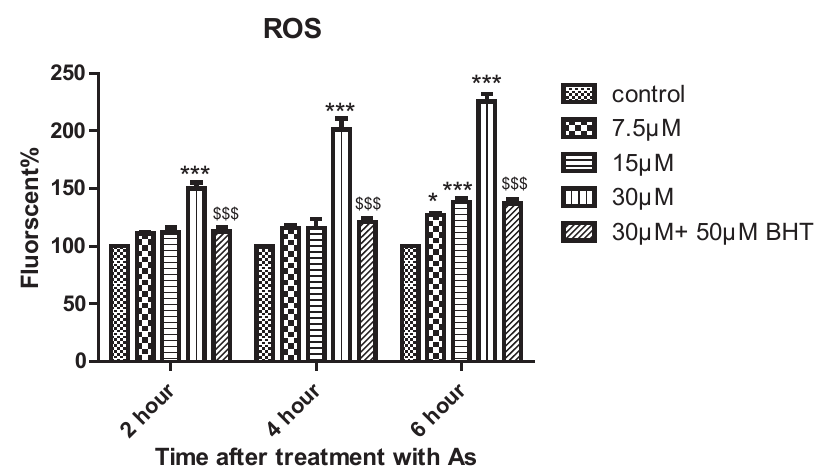
Figure 2: ROS generation in human lymphocyte after treatment with As. Induction of ROS by As was significant (P < 0.05) at all concentrations at 6 h and only at highest concentration at 2 and 4 h in comparison with control. Buyhylatedhydroxy toluene (BHT), an antioxidant, inhibited As-induced generation of ROS in human lymphocytes. * (P < 0.05) and *** (P < 0.001): significant difference compared to the control group. $$$: significant difference with 30 µM